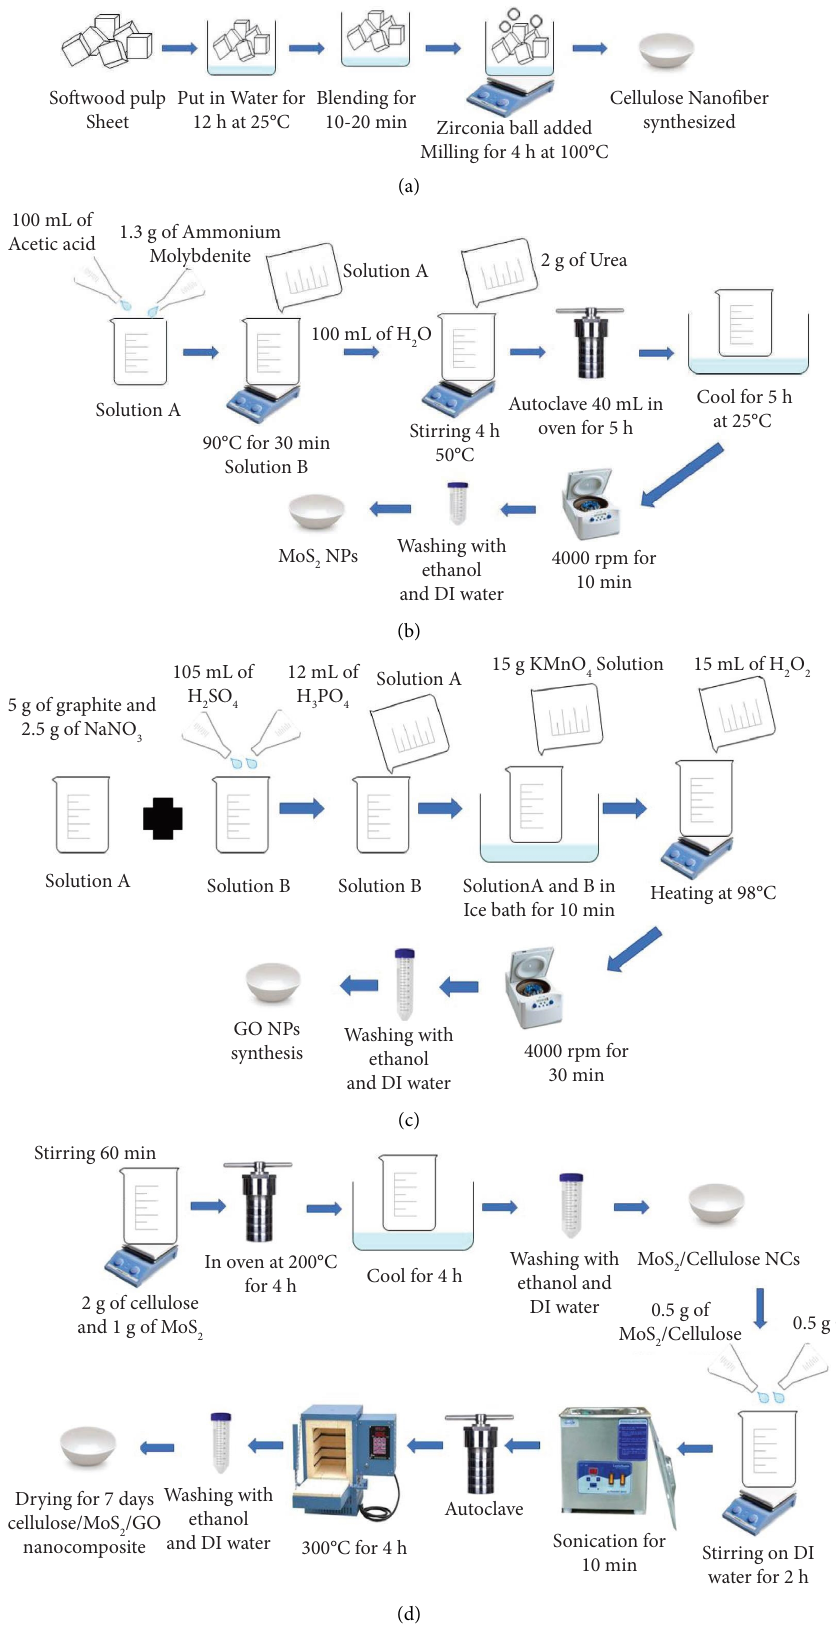
Figure 1: (a) Synthesis of cellulose NPs. (b) Synthesis of MoS